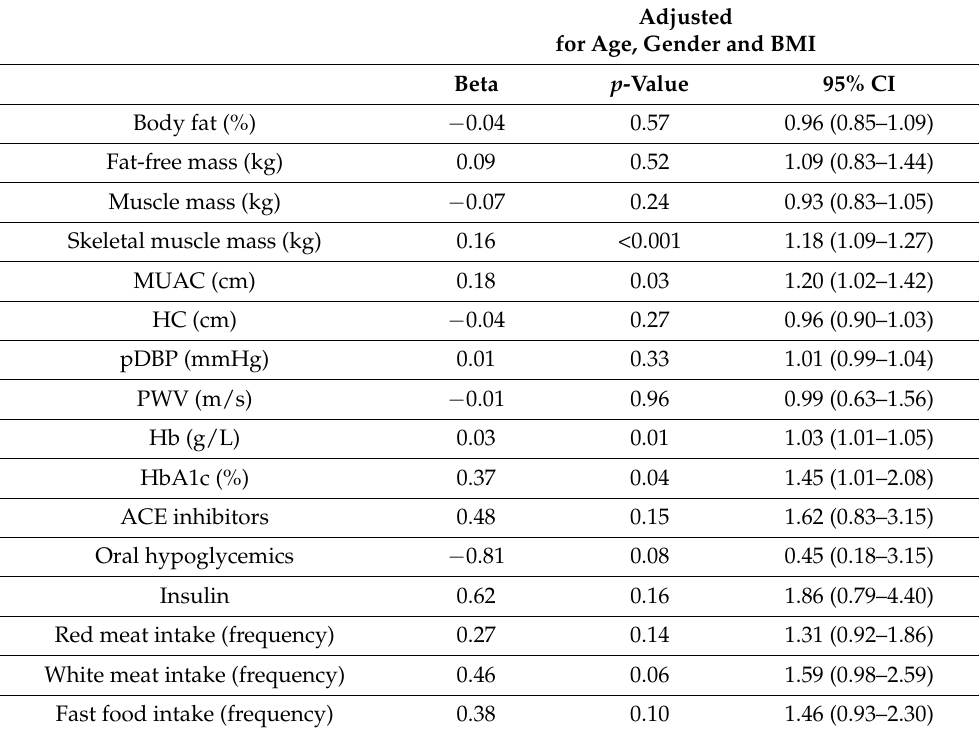
Table 4. Association between phase-angle and measured parameters adjusted for age, gender, and